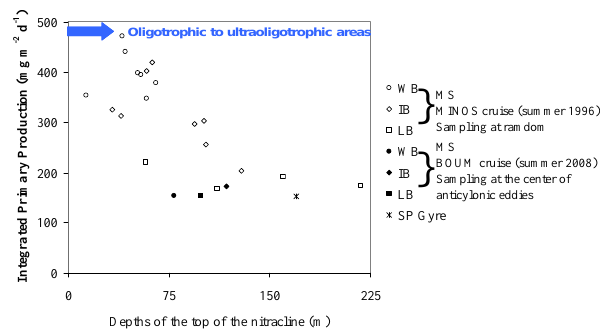
Fig. 9. Integrated primary production vs. depth at the top of the nitracline. Data from the MS in the western basin (WB), the Ionian basin (IB) and the Levantine basin (LB): MINOS cruise (Moutin and Raimbault, 2002) and BOUM cruise, and data from the most oligotrophic area in the world ocean, the South Pacific gyre (SP: T. Moutin, unpublished